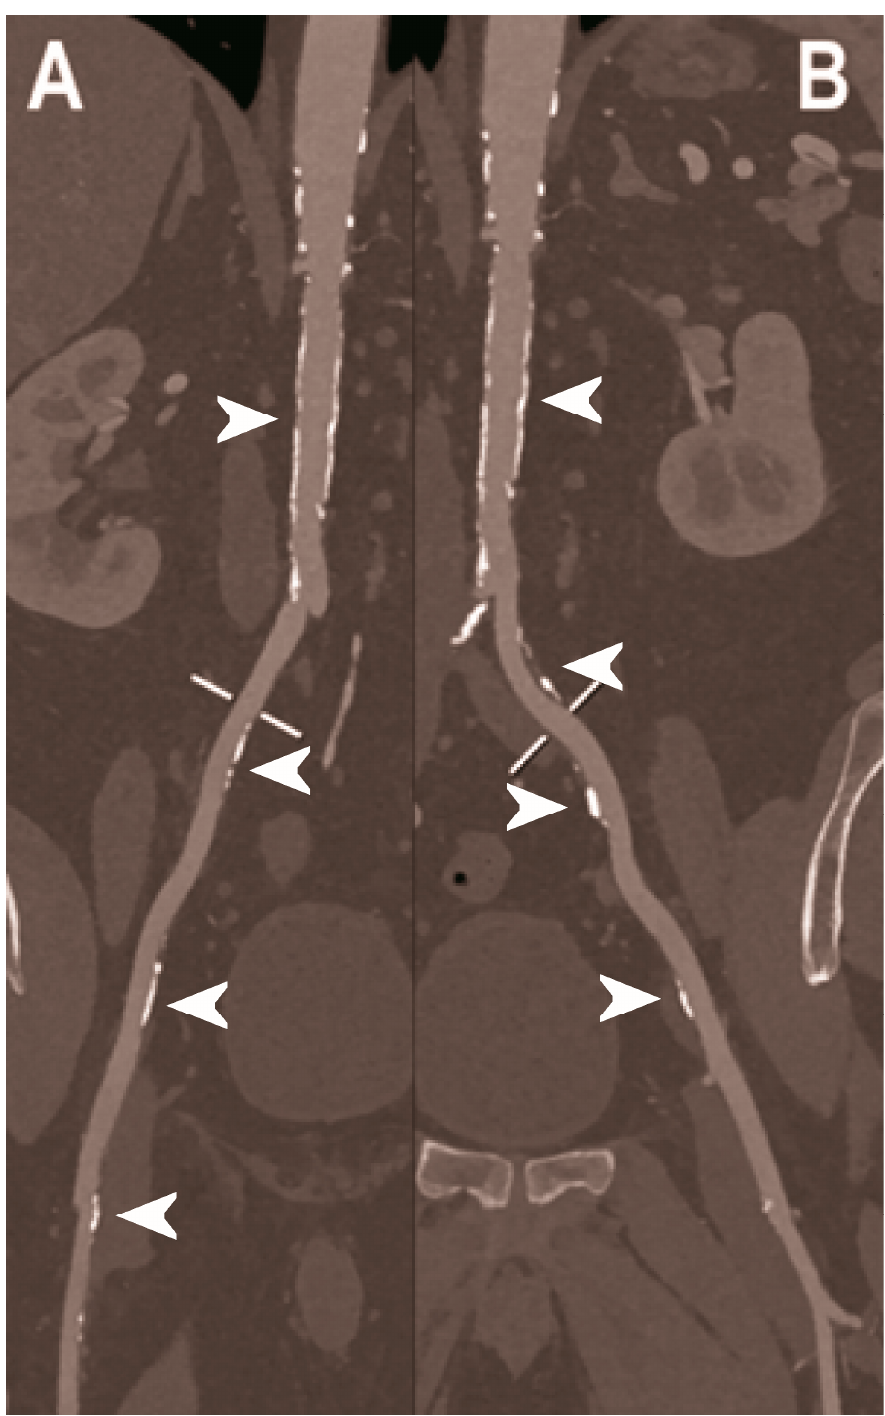
Figure 7. Abdominal CT angiography using photon-counting computed tomography. The figure shows advanced multiplanar reconstructions of an abdominal aorta and ilio-femoral arterial axes derived from a photon-counting CT (Scanner: NAEOTOM Alpha, Siemens) acquisition ( A , B ). In ( A ) the projection starts in the abdominal aorta at the level of thoraco-abdominal junction and ends in the right common femoral artery while in ( B ) it ends in the left common femoral artery. While there are significant calcifications along the vessels (arrowheads in A , B ), the vessel wall is so sharp that the fact that there is no lumen reduction appears to be quite natural as compared to the common blooming effect seen with conventional energy-integrating